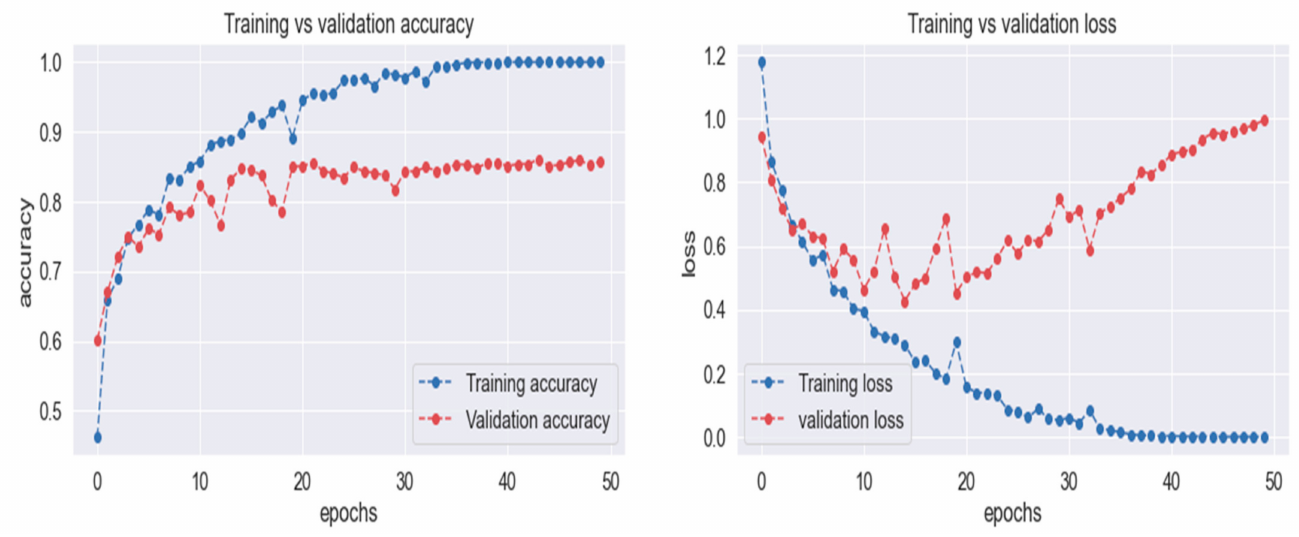
Figure 8. Training accuracy, validation accuracy, training loss and validation